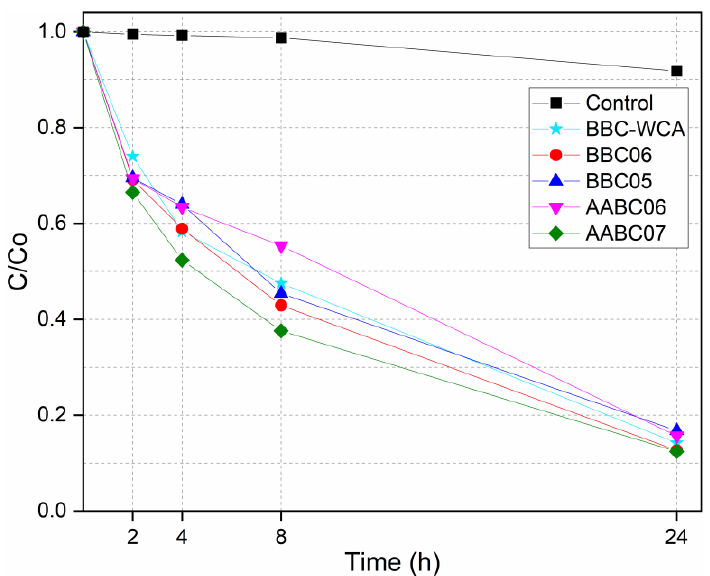
Figure 16. Dye concentration versus time in the dark.